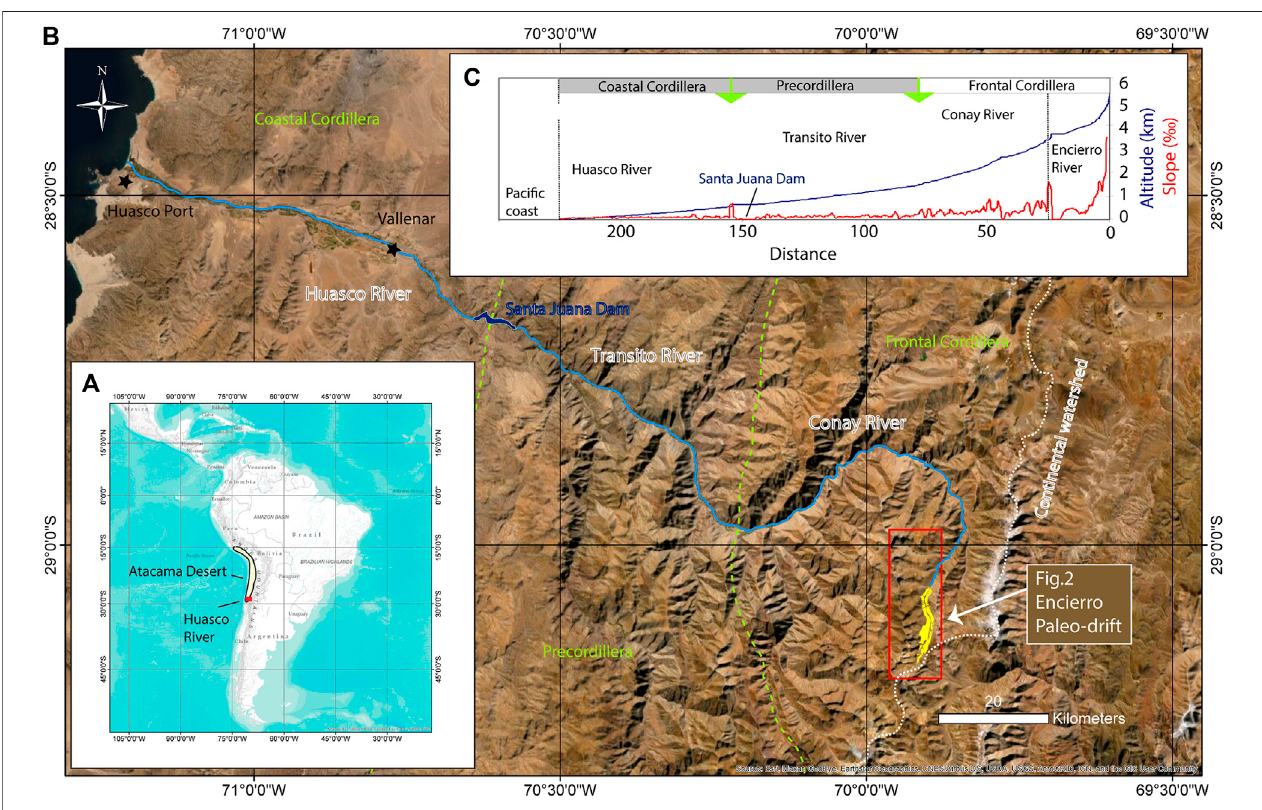
FIGURE 1 | Location map of the Encierro Valley in the Southern Atacama Desert. (A) Inset map with study area in South America. (B) DEM and morphostructural segments of the western slopes of the Andes. (C) Longitudinal Encierro-Huasco River topographic pro fi le between the Encierro Valley and Paci fi c Coast.